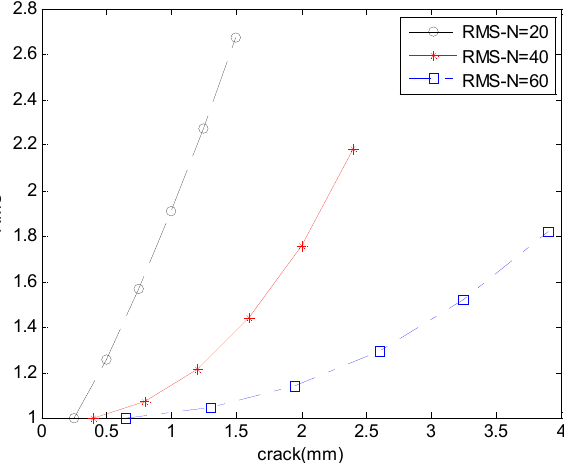
Figure 28. Vibration response of cracked gear at gear number 60/60.